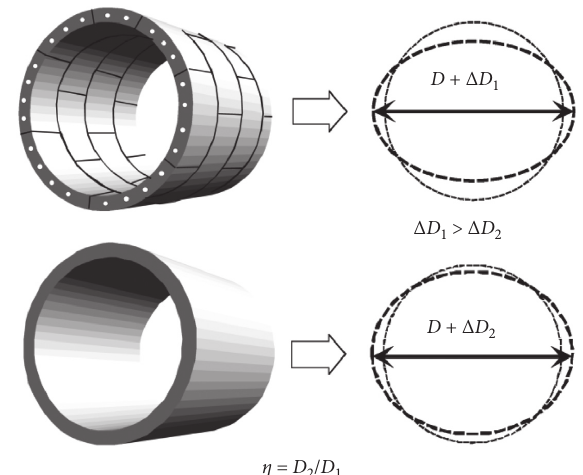
Figure 2: Concept of the effective ratio of bending rigidity [11].